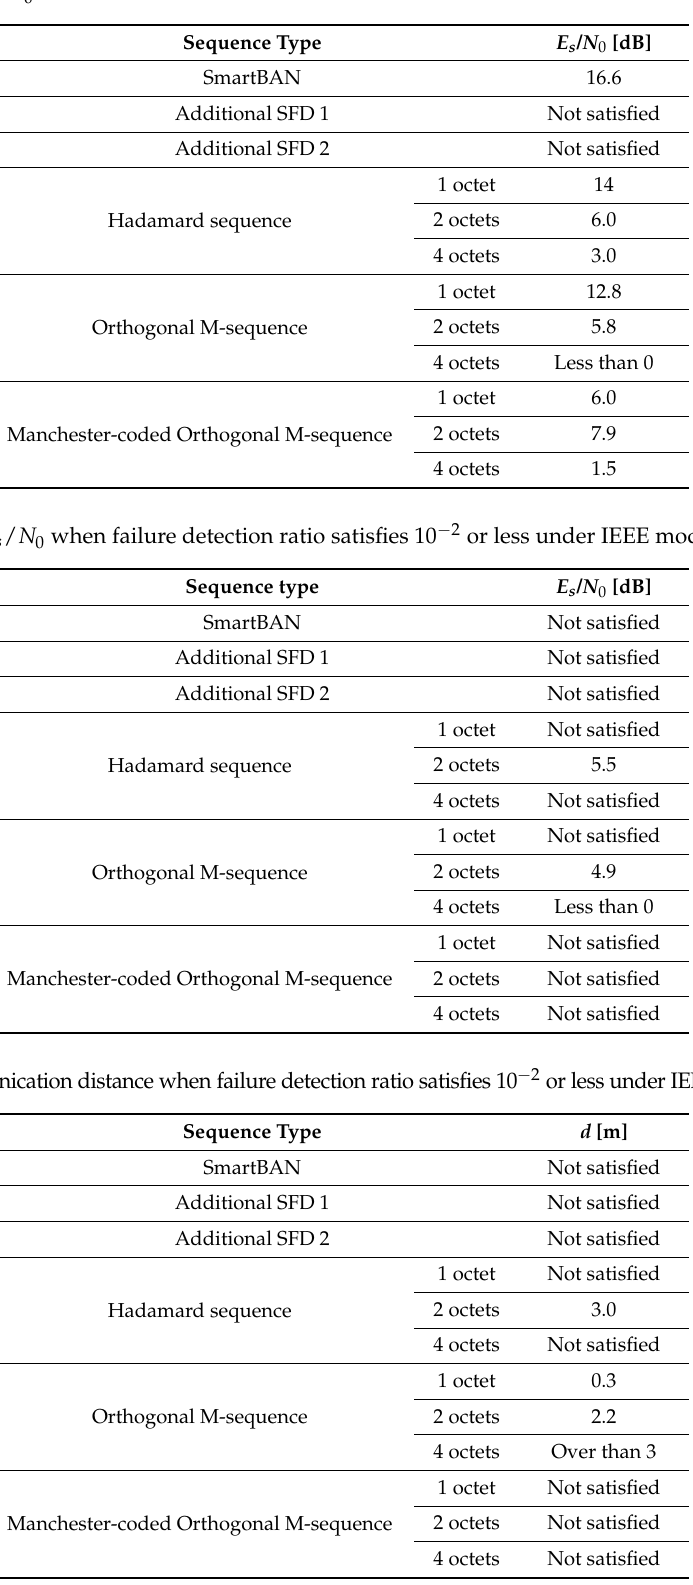
Table 6. E s / N 0 when failure detection ratio satisfies 10 − 2 or less under the AWGN channel.